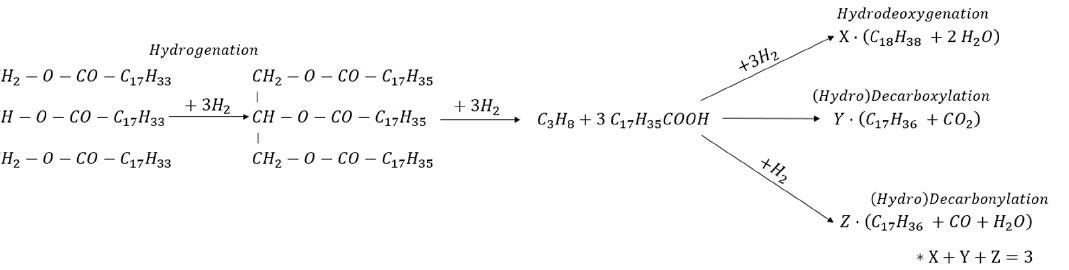
Figure 1. Triglyceride deoxygenation pathways. Tri-olein as a model molecule [12,13]. * The sum of the possible hydrotreating pathways is always three (i.e., X + Y + Z = 3). In the frame of catalysts, the current commercial hydrotreating catalysts (i.e., NiMoSx or CoMoSx supported by Al 2 O 3 /SiO 2 supports) are usable for co-processing. However, this